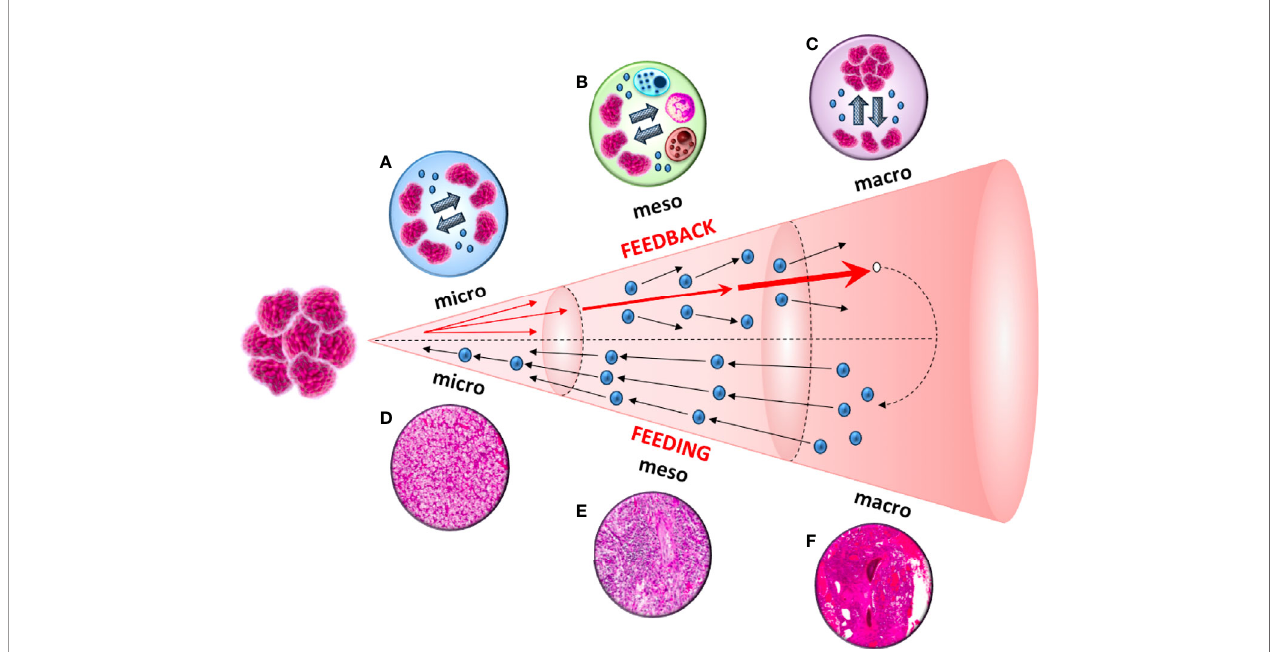
FIGURE 2 | A diagram of the feeding and feedback cycles, showing the geometric increase of three orders of magnitude (micro, meso and macro) in tumor microenvironment. Tumor-derived exosomes can increase the invasiveness and motility of recipient cells. This exosome-mediated communication occurs at three different levels: between cancer cells in the primary tumor (micro), between cancer and immune cells (meso) and between cancer cells from the primary tumor to the metastatic sites